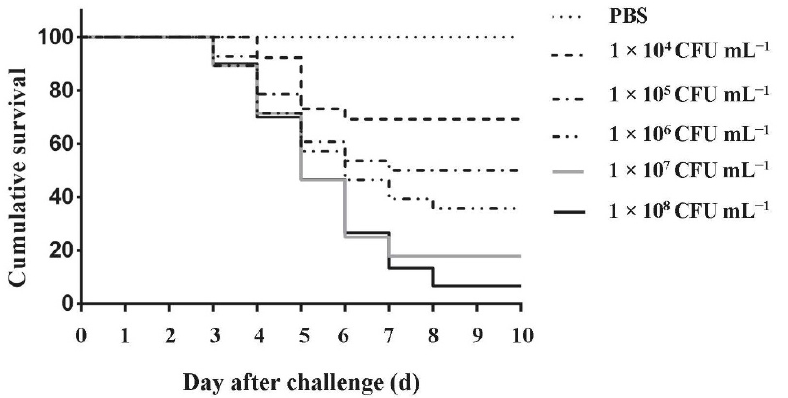
Figure 6. Survival rates of largemouth bass specimens challenged with different doses of A. caviae WH21406 for 10 days post ‐ infection.